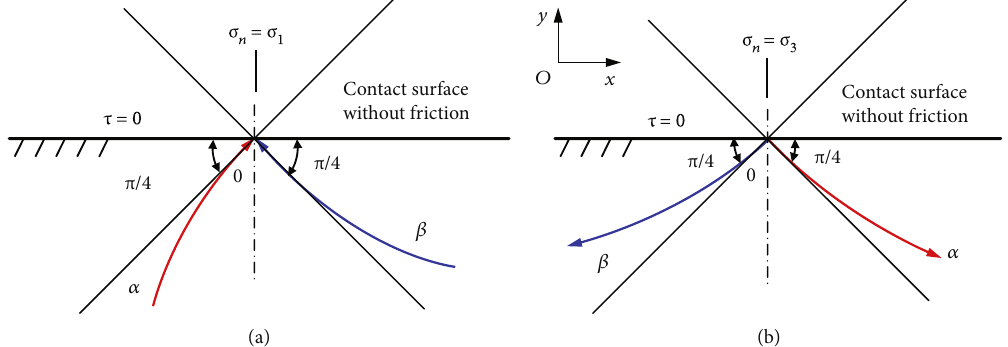
Figure 5: Slip-line characteristics on contact surface without friction: (a) normal stress is σ